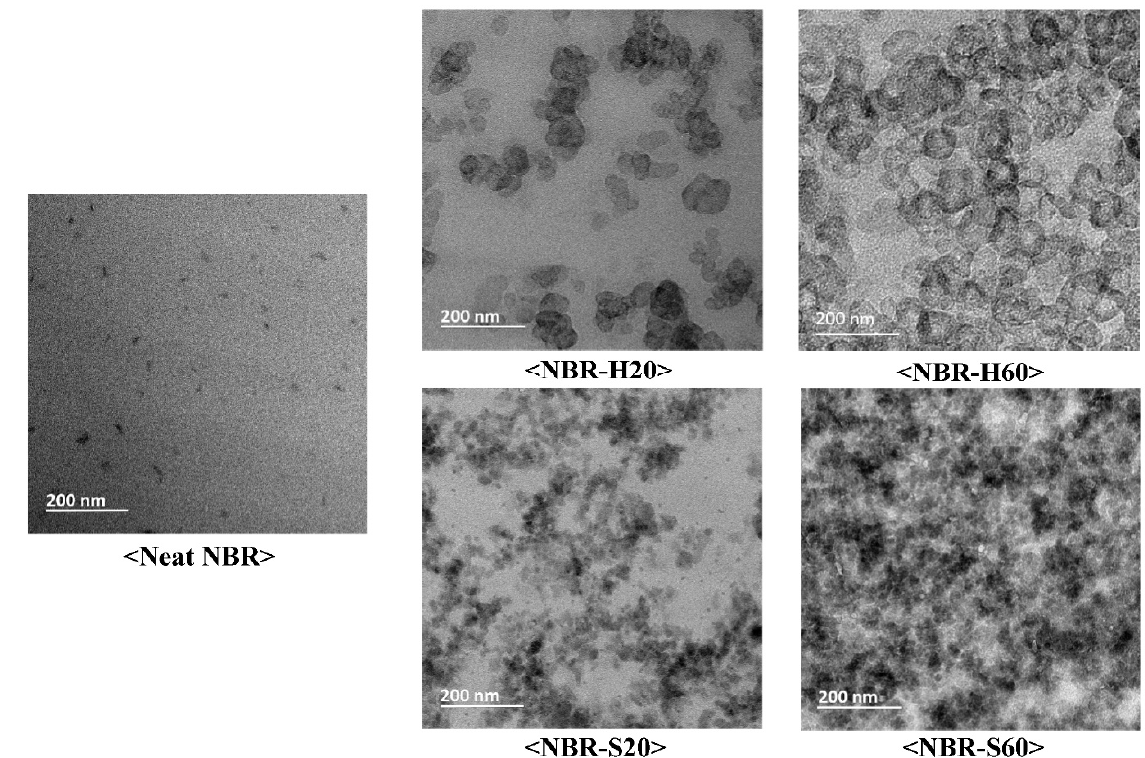
Figure 1. TEM image of neat NBR, NBR-H20, NBR-H60, NBR-S20, and NBR-S60.